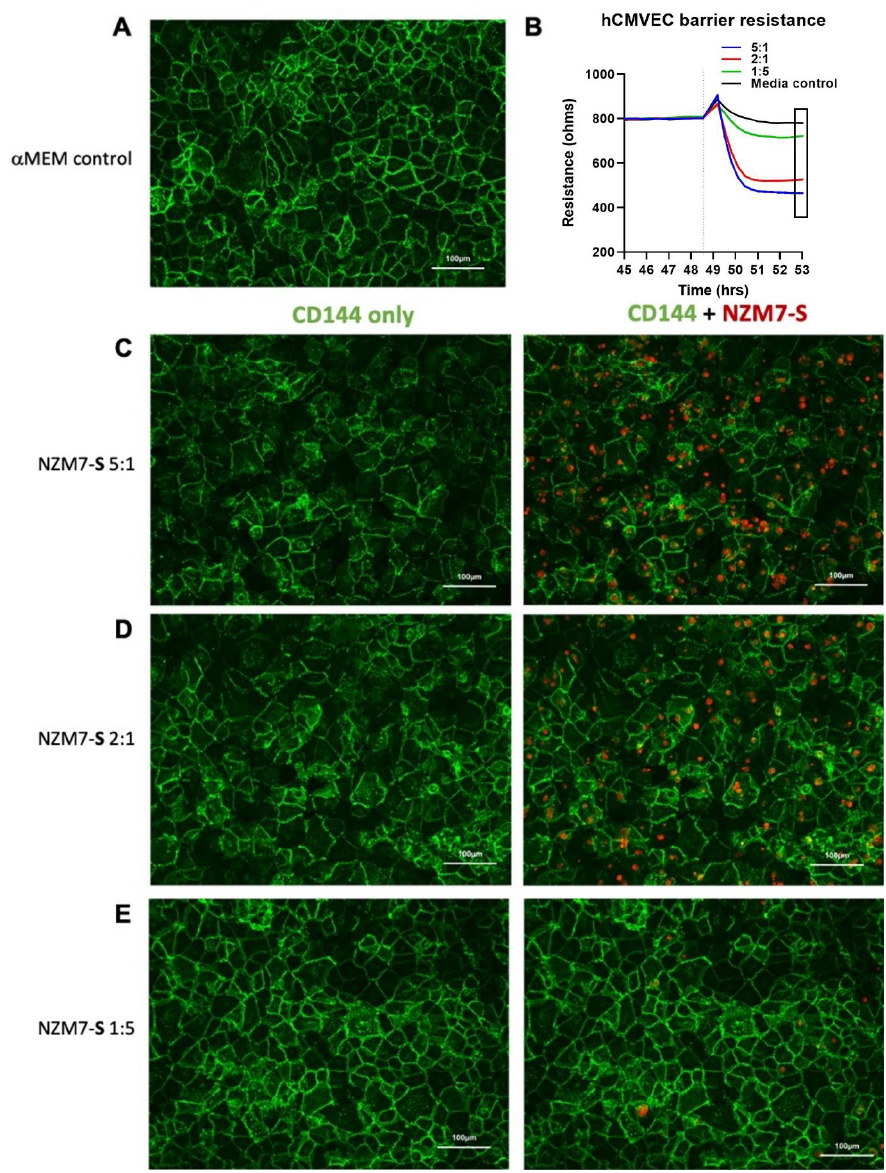
Figure 6. Human cerebral microvascular endothelial cell CD144 staining after NZM7-S treatment at varied concentrations. hCMVECs were seeded at 20,000 cells per well. NZM7-S were live stained with CytoTrack Red (CTR; red in image) and applied to the apical face of a confluent endothelial monolayer. Cells were co-cultured for 4 h, washed and then fixed. Junctions were stained with anti-CD144 (green). ( A ) An image from the media control well. ( B ) A paired ECIS experiment, where the boxed region shows the point of fixing for the ICC images (4 h). ( C , D,E ) The images of the melanoma-treated wells at different E:T ratios, noted on the left side of the panel. Images were acquired on the Operetta CLS imaging system. Full view images scale bar = 100 µm. Images are representative of 2 independent experiments.